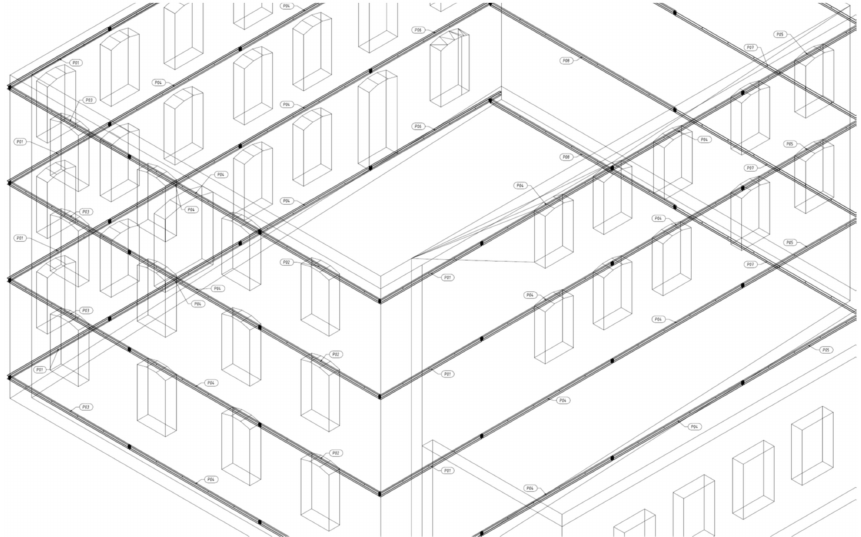
Figure 13. Proposed reinforcement solution for studied building—axonometry.